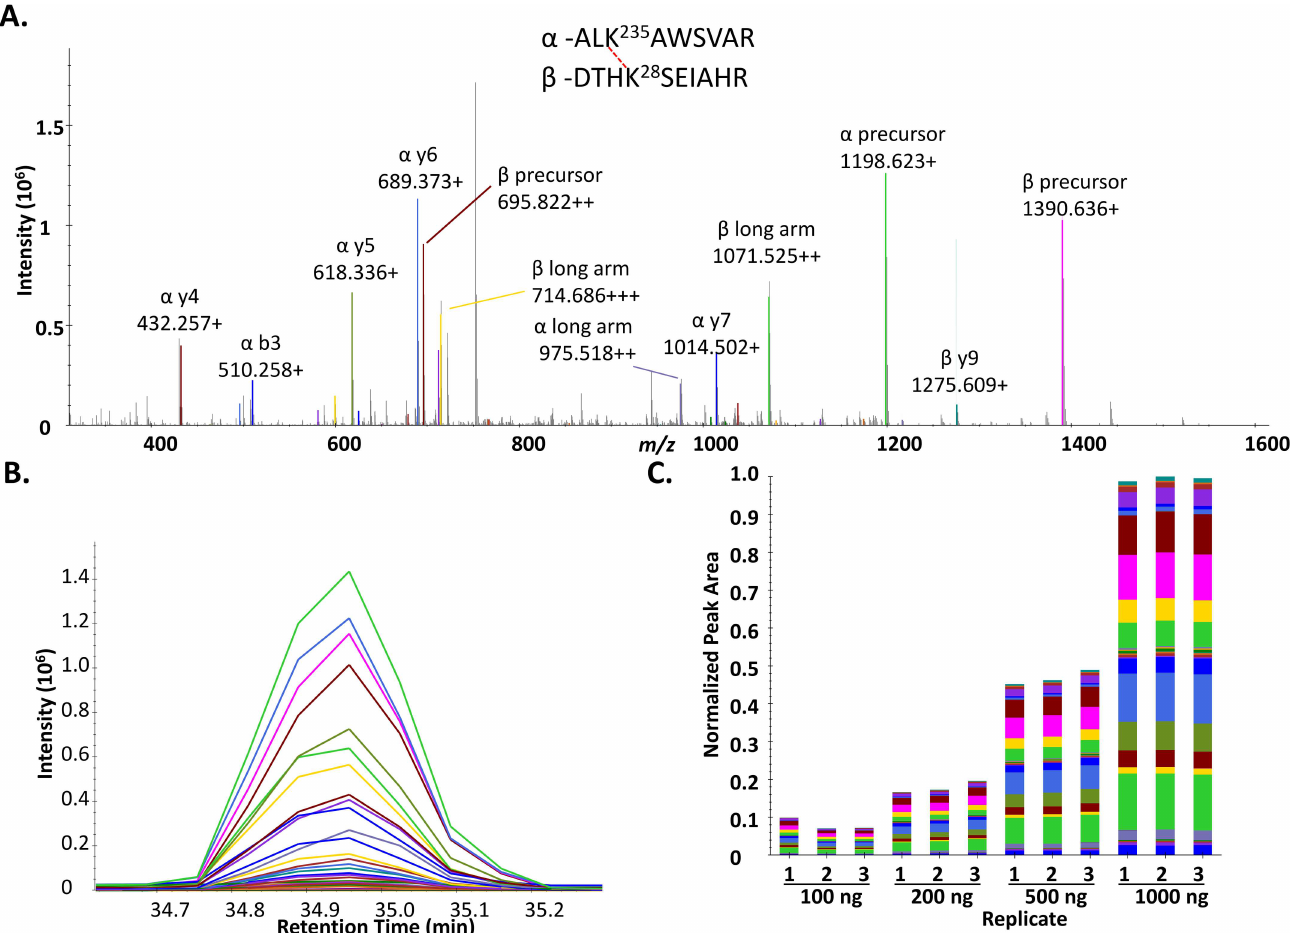
Fig 2. Quantification of BSA cross-linked peptide pairs with Skyline. A. MS2 spectrum for the cross-linkedpeptidepair linkingresidues K235-K28 (ALK 235 AWSVAR_DTHK 28 SEIAHR), obtained from a 500 ng injectionof cross-linkedBSA digest. B. Extracted ion chromatograms for the PRM transitionsobserved for the cross-linkedpeptidepair in A. C. Skyline generatedbar plot illustrating the normalized peak areas for the cross-linked peptidepair linkingK28-K235. Peak areas are shown for triplicate analysesof varyinginjectionamounts (100, 200, 500, and 1000 ng cross-linked BSA digest). Bars are color coded to indicatethe contribution of each individual transition to the total peak area and match the color scheme in panel B.